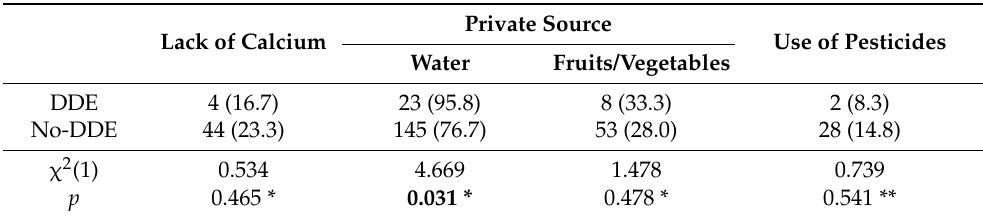
Table 6. Statistical comparisons between DDE and no-DDE groups regarding lack of calcium, sources of water and fruits/vegetables and use of pesticides—N (%).